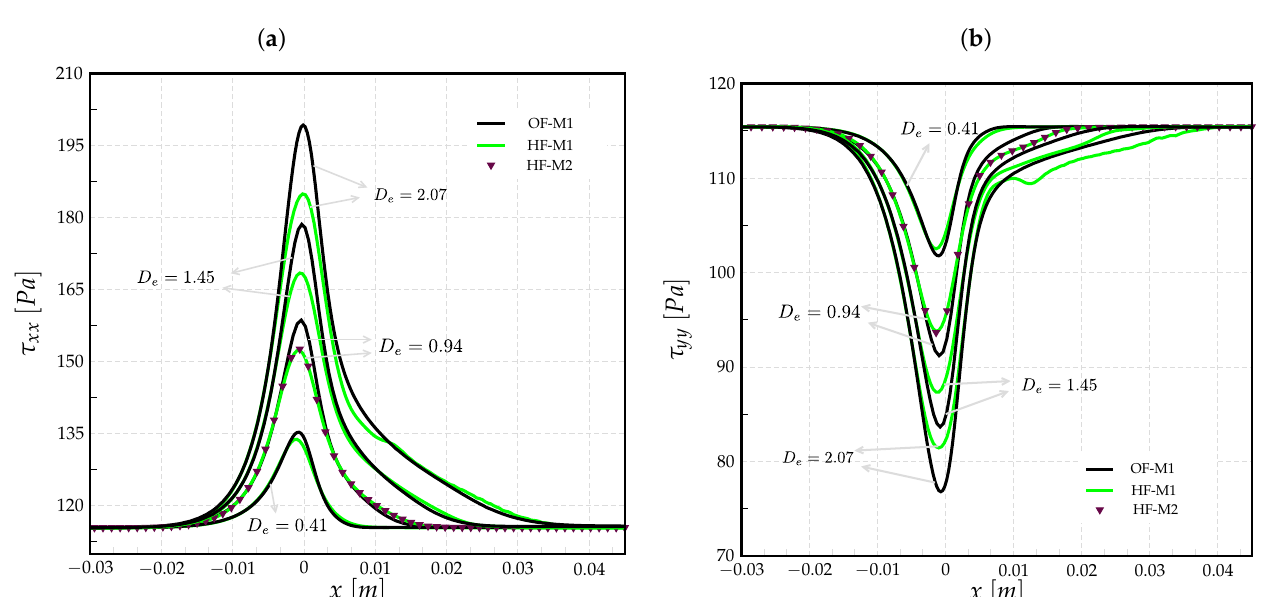
Figure 11. Numerical results for ( a ) τ xx and ( b ) τ yy using HiGFlow system (HF-M1 e HF-M2) and OpenFOAM system (OF-M1).